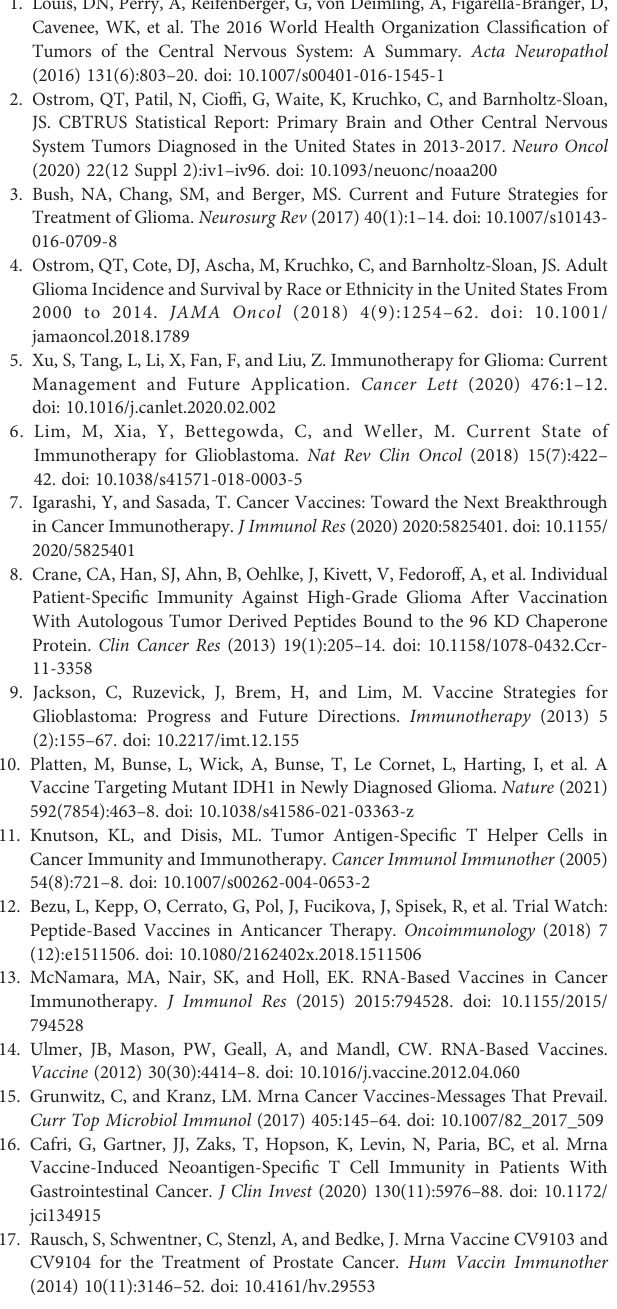
Supplementary Figure 1 | Procedures for the analysis of antigen detection and GBM immune subtypes identi fi cation. Supplementary Figure 2 | Association between the expression of tumor antigens with GBM RFS. Kaplan-Meier curves showing PFS of GBM patients strati fi ed on the basis of (A) ARHGAP9, (B) ARHGAP30, (C) CLEC7A, (D) ARPC1B, (E) PLB1 and (F) MAN2B1 expression level. p-value <0.05 was considered statistically signi fi cant.